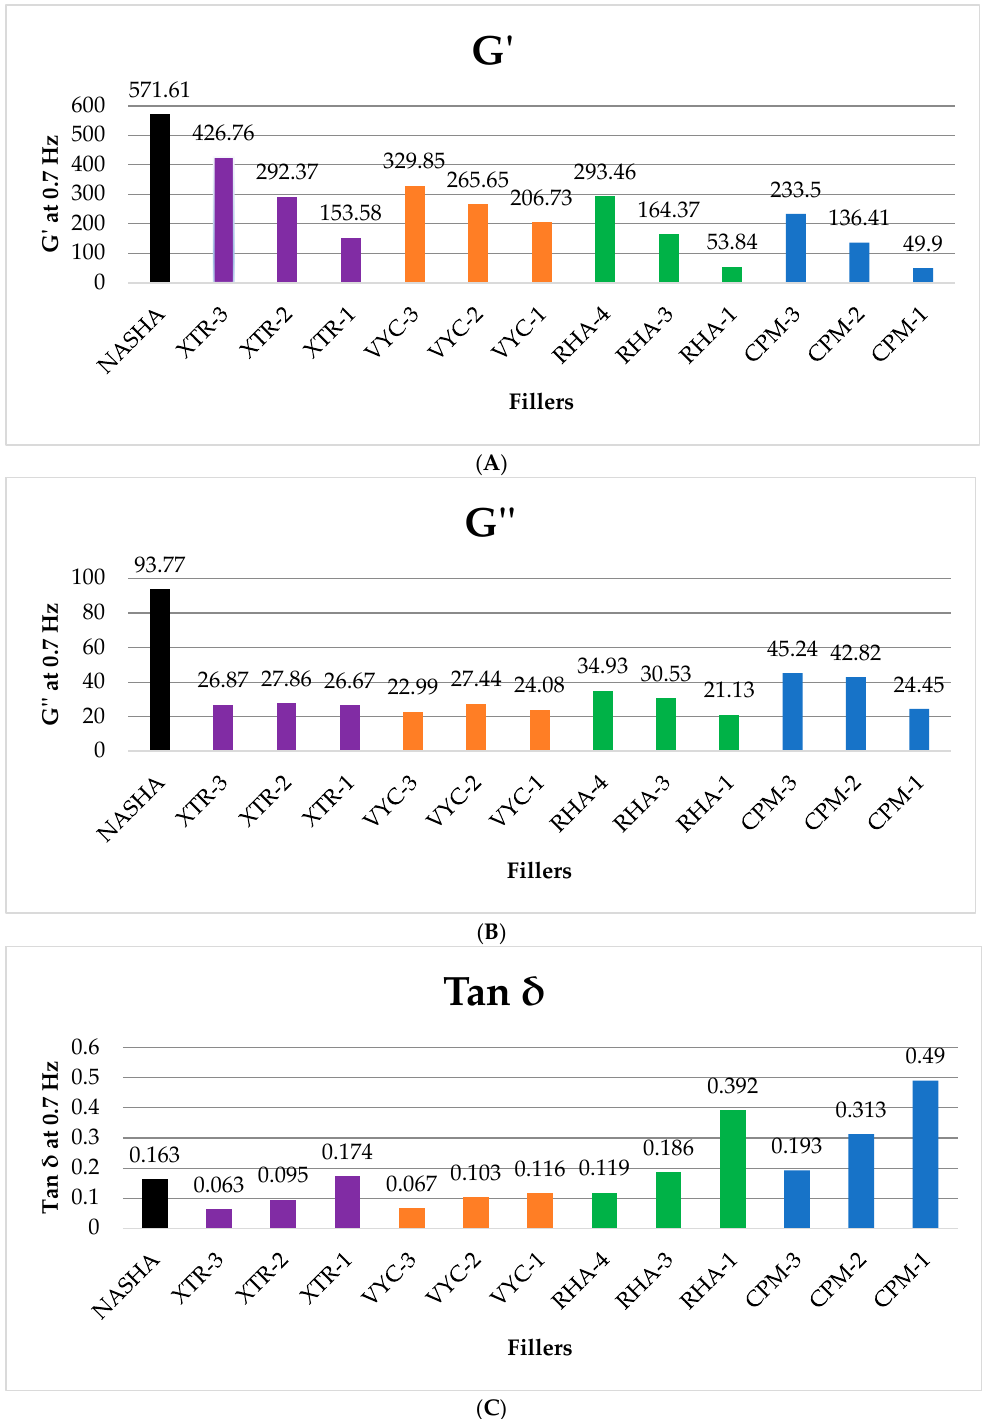
Figure 2. Summary of frequency sweep and amplitude sweep measurements of the HA fillers evaluated. A comparison of the (A) elastic moduli (G ′ ), (B) viscous moduli (G ′′ ), and (C) tan δ of fillers made with varying crosslinking technologies.